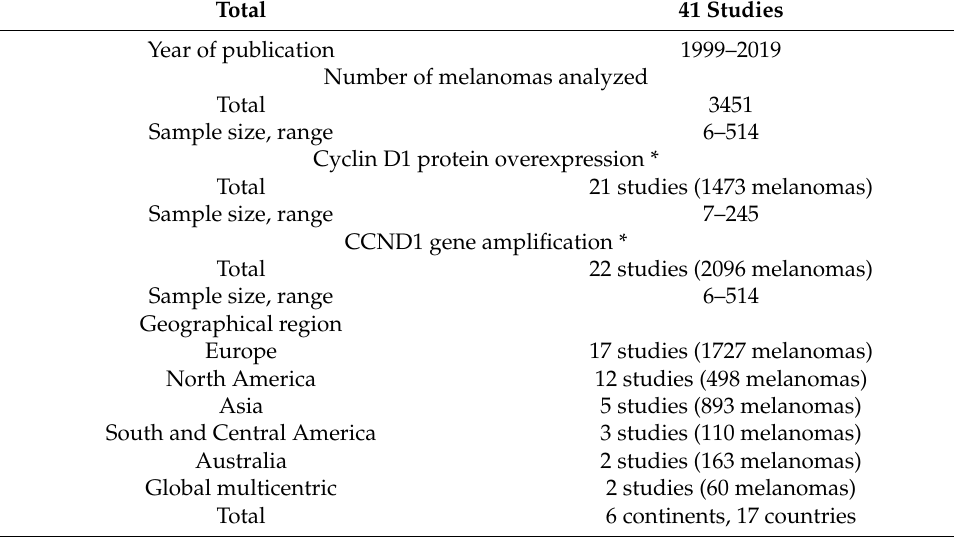
Figure 1. Flow diagram of the identification and selection of relevant studies, analyzing the prognostic and clinicopathological significance of CCND1 /cyclin D1 alterations in melanomas. Table 1. Summarizes the main characteristics of reviewed studies. Table S2 (in Supplementary Mate- rials, pp. 6–12) exhibits in detail the characteristics (type of melanoma, affected sites, and methods) of each study. * —Two studies analyzed both CCND1 /cyclin D1 alterations (118